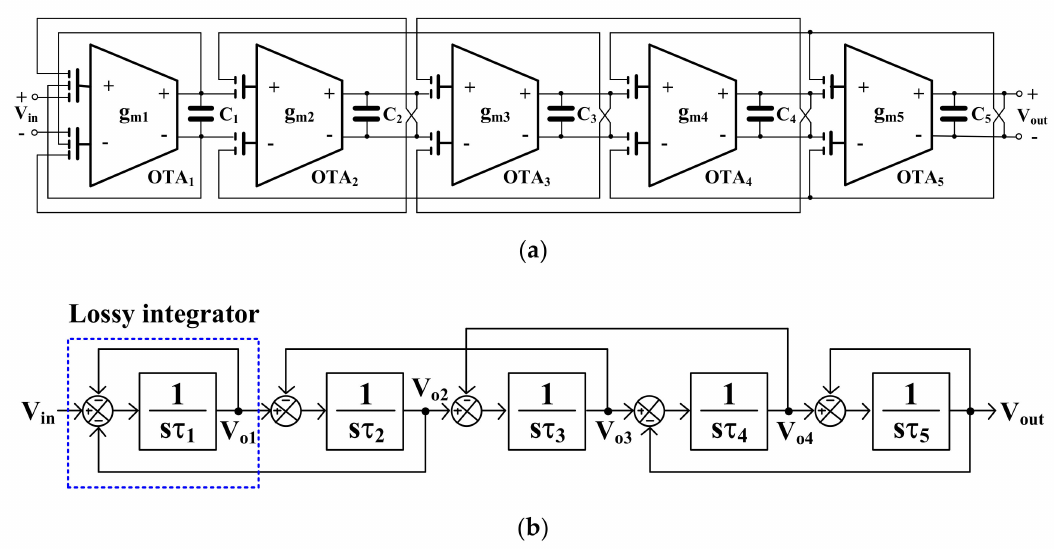
Figure 8. ( a ) Proposed fifth-order Butterworth low-pass filter, ( b ) signal flow